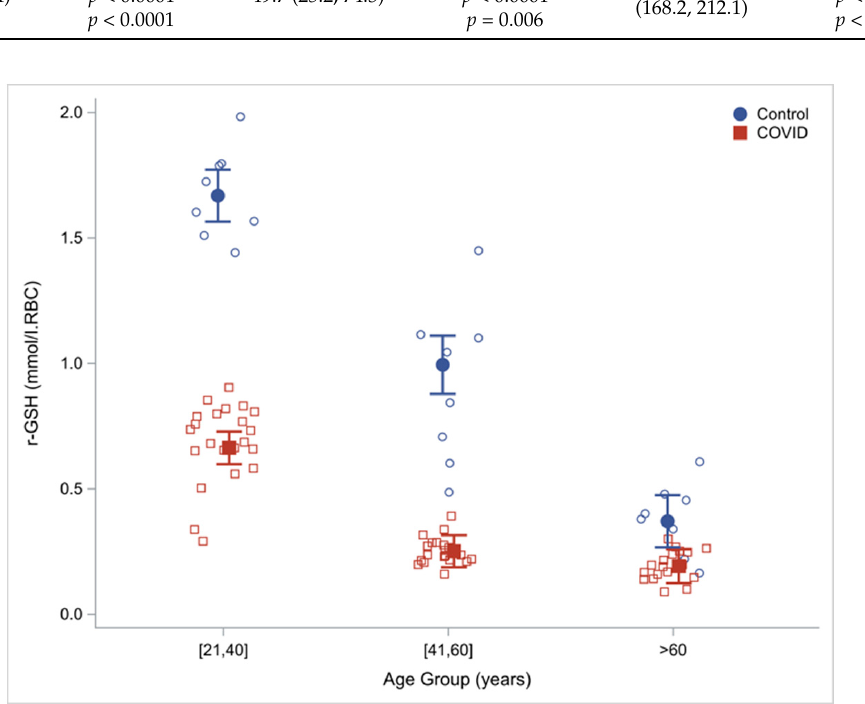
Figure 1. Intracellular reduced glutathione concentrations by age and cohort (COVID-19 patients vs. uninfected controls) with regression estimated means (95% CI) adjusting for cohort, age, group and sex. Table 2. GSH and oxidative stress. Data are reported as means ± SD.